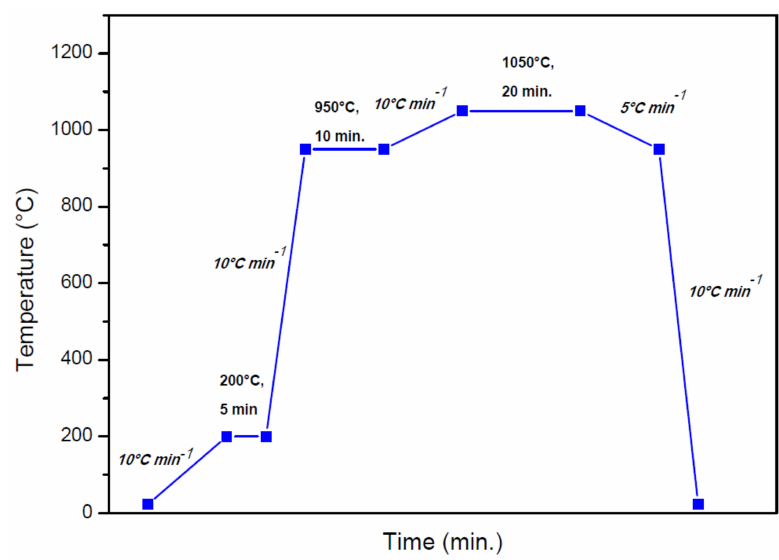
Figure 3. Vacuum furnace heating/cooling